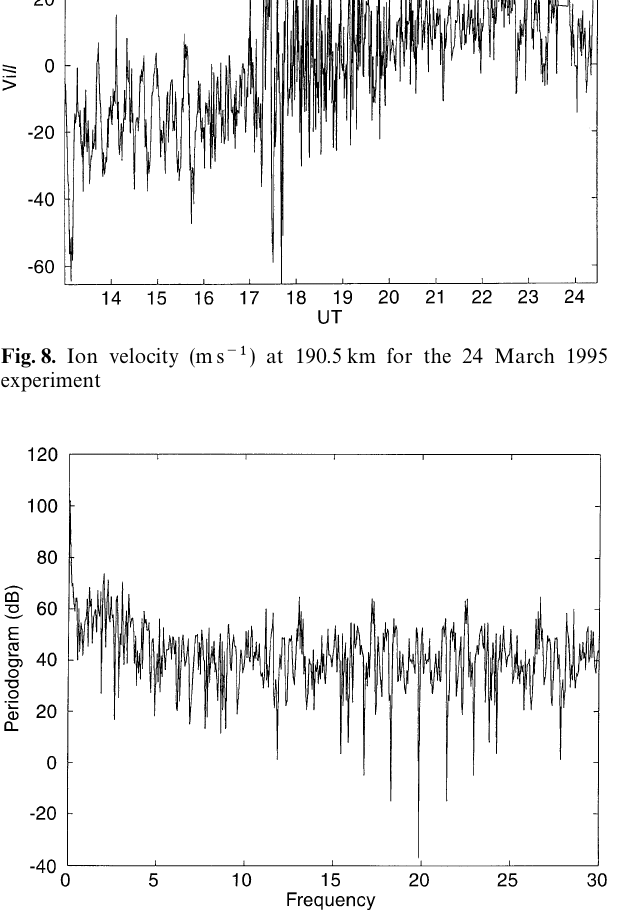
Fig. 9. Square modulus of the Fourier transform of the ion velocity; frequencies are in h (cid:126)(cid:49)